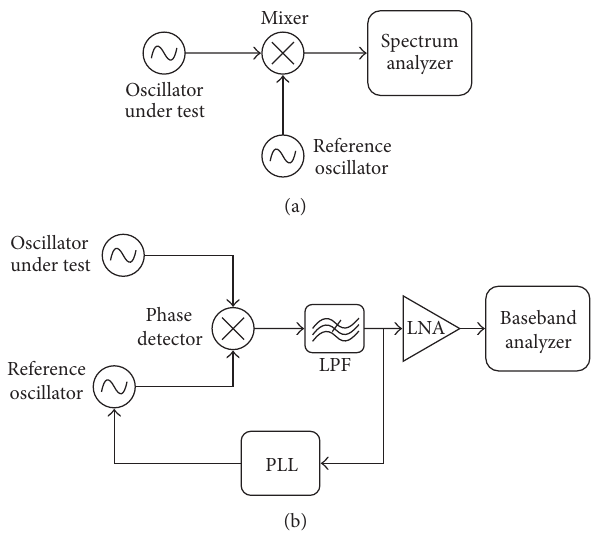
Figure 1: Phase noise measurement methods with reference oscilla- tor. (a) Direct downconversion method and (b) PLL method.